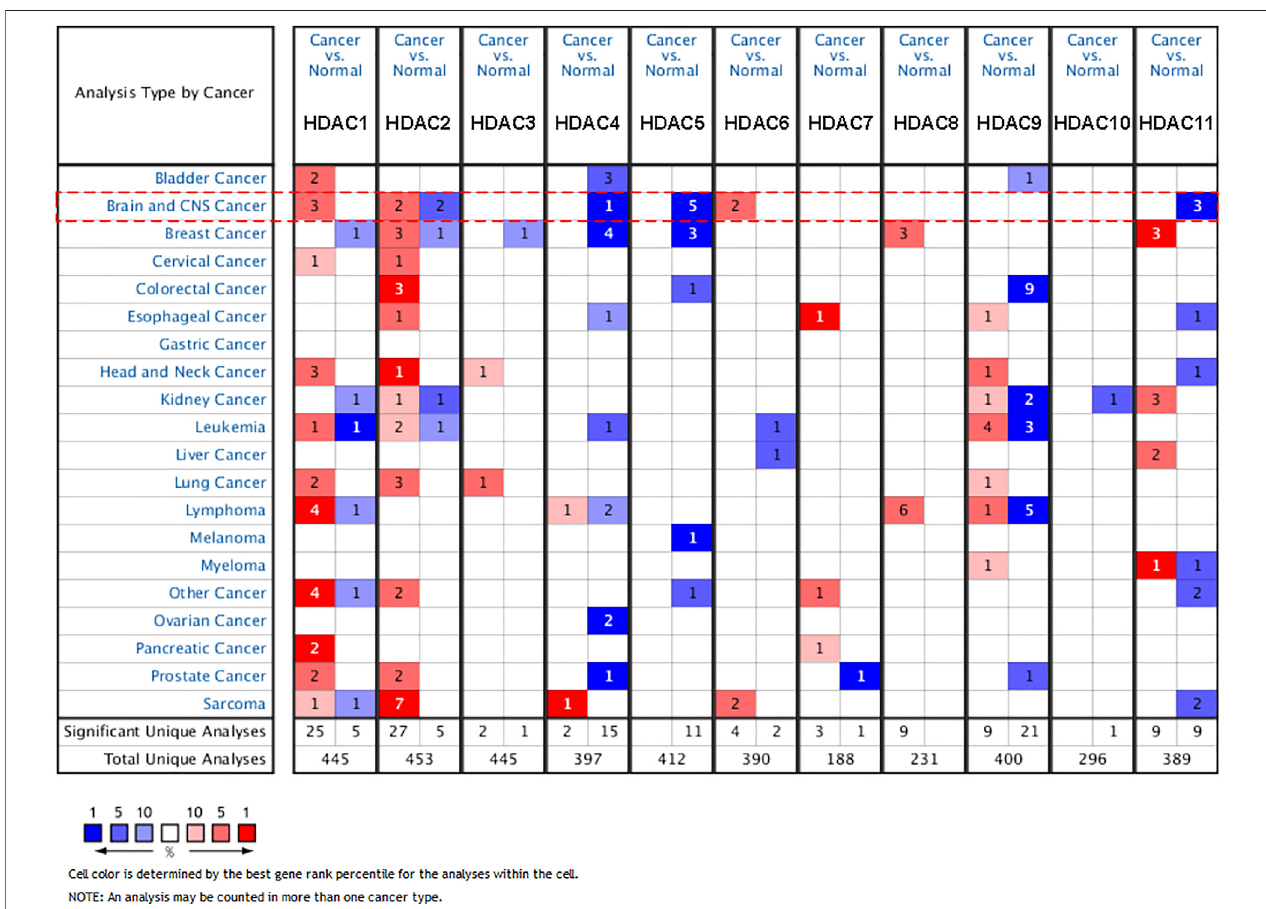
FIGURE1| Expression microarray ofHDACfamilyacrossvarietiesofcancers and corresponding controlgroups in ONCOMINE. Thenumber incells indicated the signi fi cant datasets showing the differentially expressed genes of the HDAC family. The red color in the cell was for upregulation, and the blue color was for downregulation. The student ’ s t-test was used to compare the different transcriptional values. The threshold was set as p -value < 0.01, fold-change (cid:1) 2, gene rank < 10%.